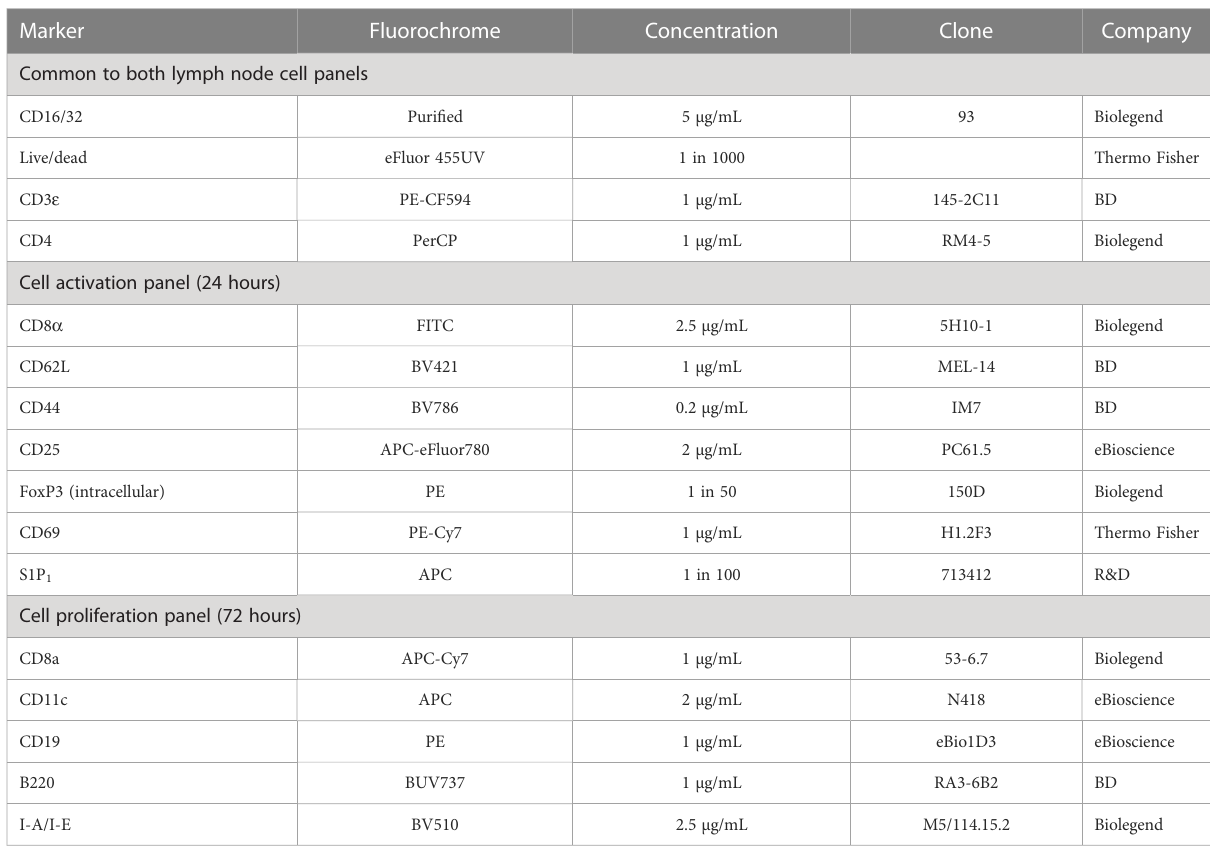
TABLE 3 List of fl ow cytometry